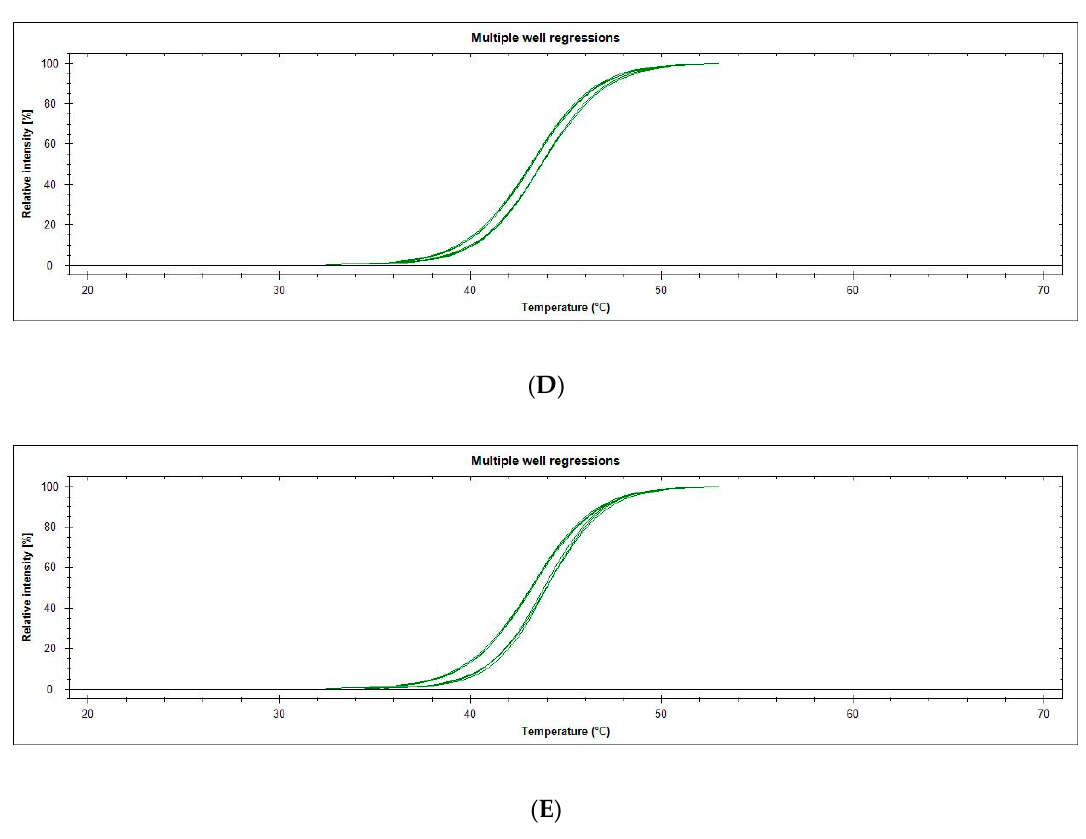
Figure 3. ( A ) Bar graph representation of changes in thermal stability ( ∆ T agg ) of NS3 when mixed with MOC derivatives or NS4A ( n = 3). ( B – E ) Plot graphs of protein aggregation (% light intensity) increase by increasing temperature ( ◦ C). The aggregation curve of NS3 domain alone is shown in the right bundles. The left bundles are for NS3 domain mixed with peptides as follows: ( B ) NS4A 21‘–33‘ , ( C ) MOC-11, ( D ) MOC-23 and ( E ) MOC-24.